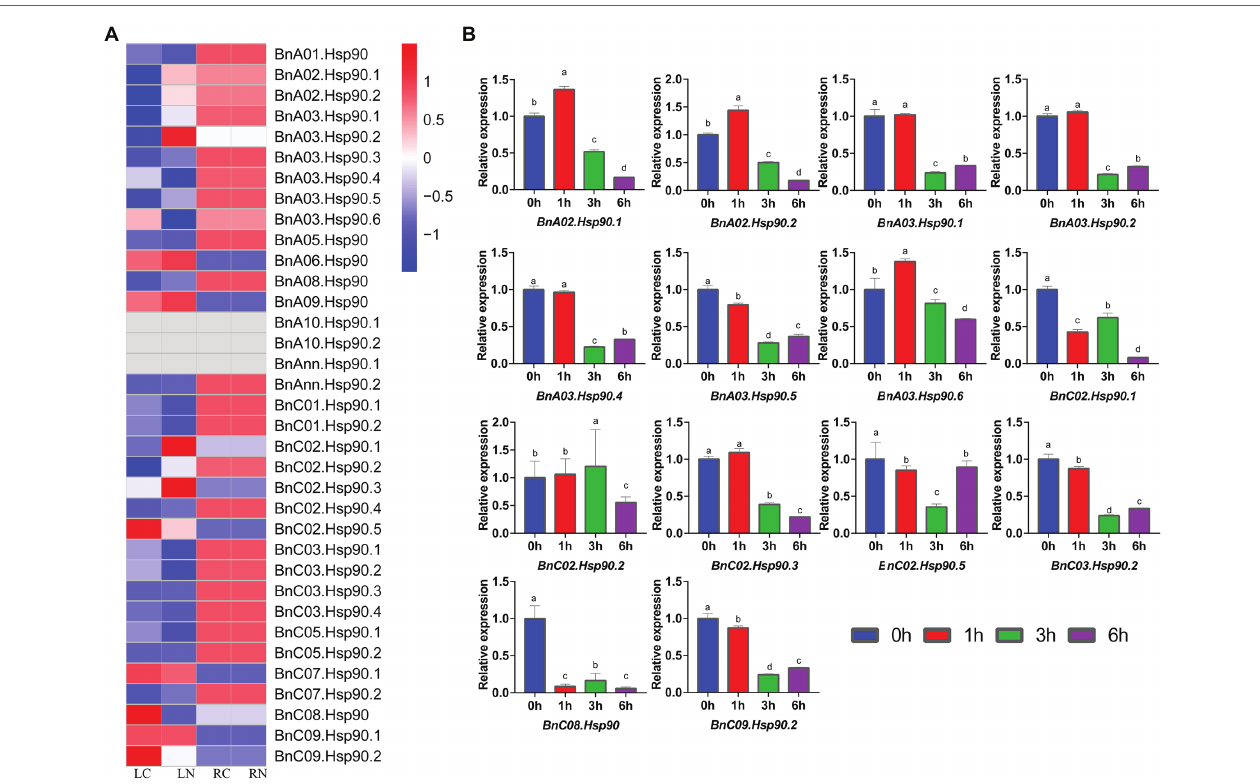
FIGURE 5 | Expression changes of BnHsp90 genes in Brassica napus after treatment with salt. (A) Differential expression of Hsp90 gene in rapeseed after salt stress from public dataset (SRA datasets, PRJNA561674). The variety used in this research is Zhongshuang No. 11. LC, leaf control group; LN, leaf treatment group; RC, root control group; RN, root treatment group. (B) Expression patterns of BnHsp90s in response to NaCl treatments. Transcript levels of BnHsp90s were analyzed by quantitative real-time PCR using actin gene as an internal control. The unstressed expression level (0 h) was regarded as a standard. Values are the mean ± SE, n =